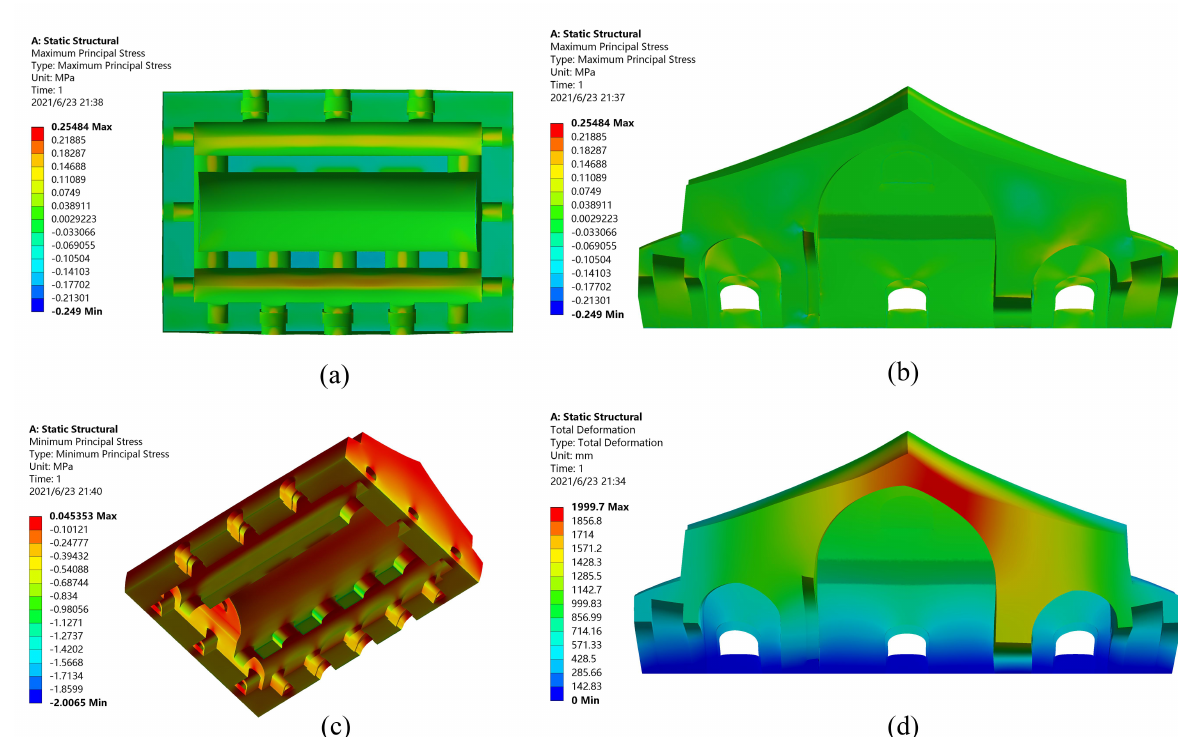
Figure 3. FEM-based structural simulation. The distribution of maximum principle stress (tensile stress) in extrado view (a) and transverse section view (b); (c) the distribution of minimum priciple stress (compressive stress ); and (d) the distribution of deformation risk.